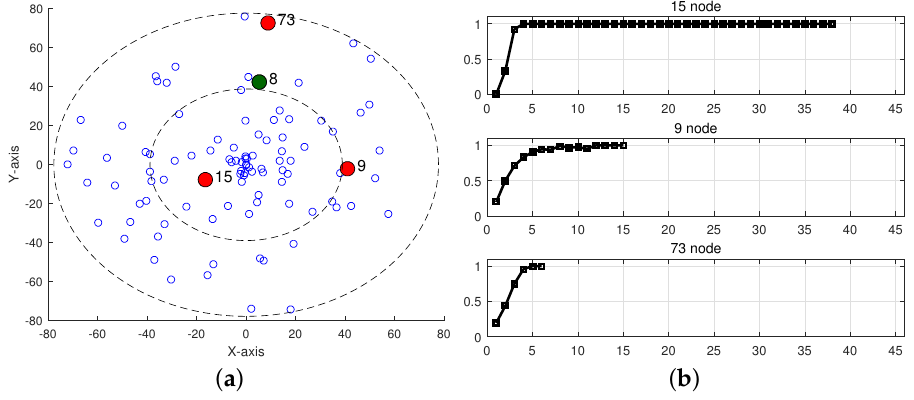
Figure 3. Examples of duplication ratio: ( a ) the network topology to measure the duplication ratio in the simulation, and ( b ) examples of duplication ratio DR i ( τ ) ( α = 1) measured in several nodes.